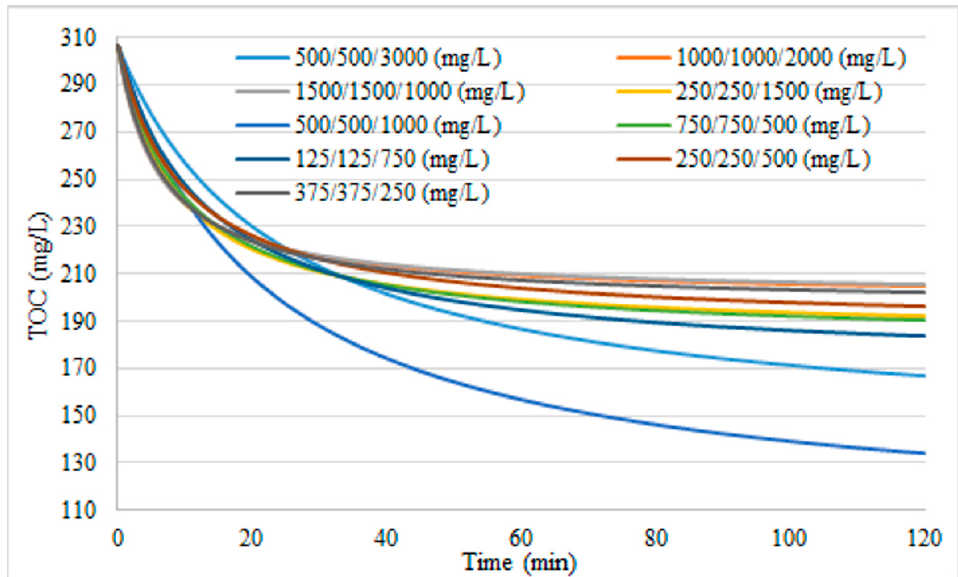
Figure 4. CW treatment results with different Fe 3 O 4 /Fe 2 O 3 /Fe 0 doses (mg/L) H 2 O 2 /COD mass ratio 1:1, UV irradiation, pH = 3.0.